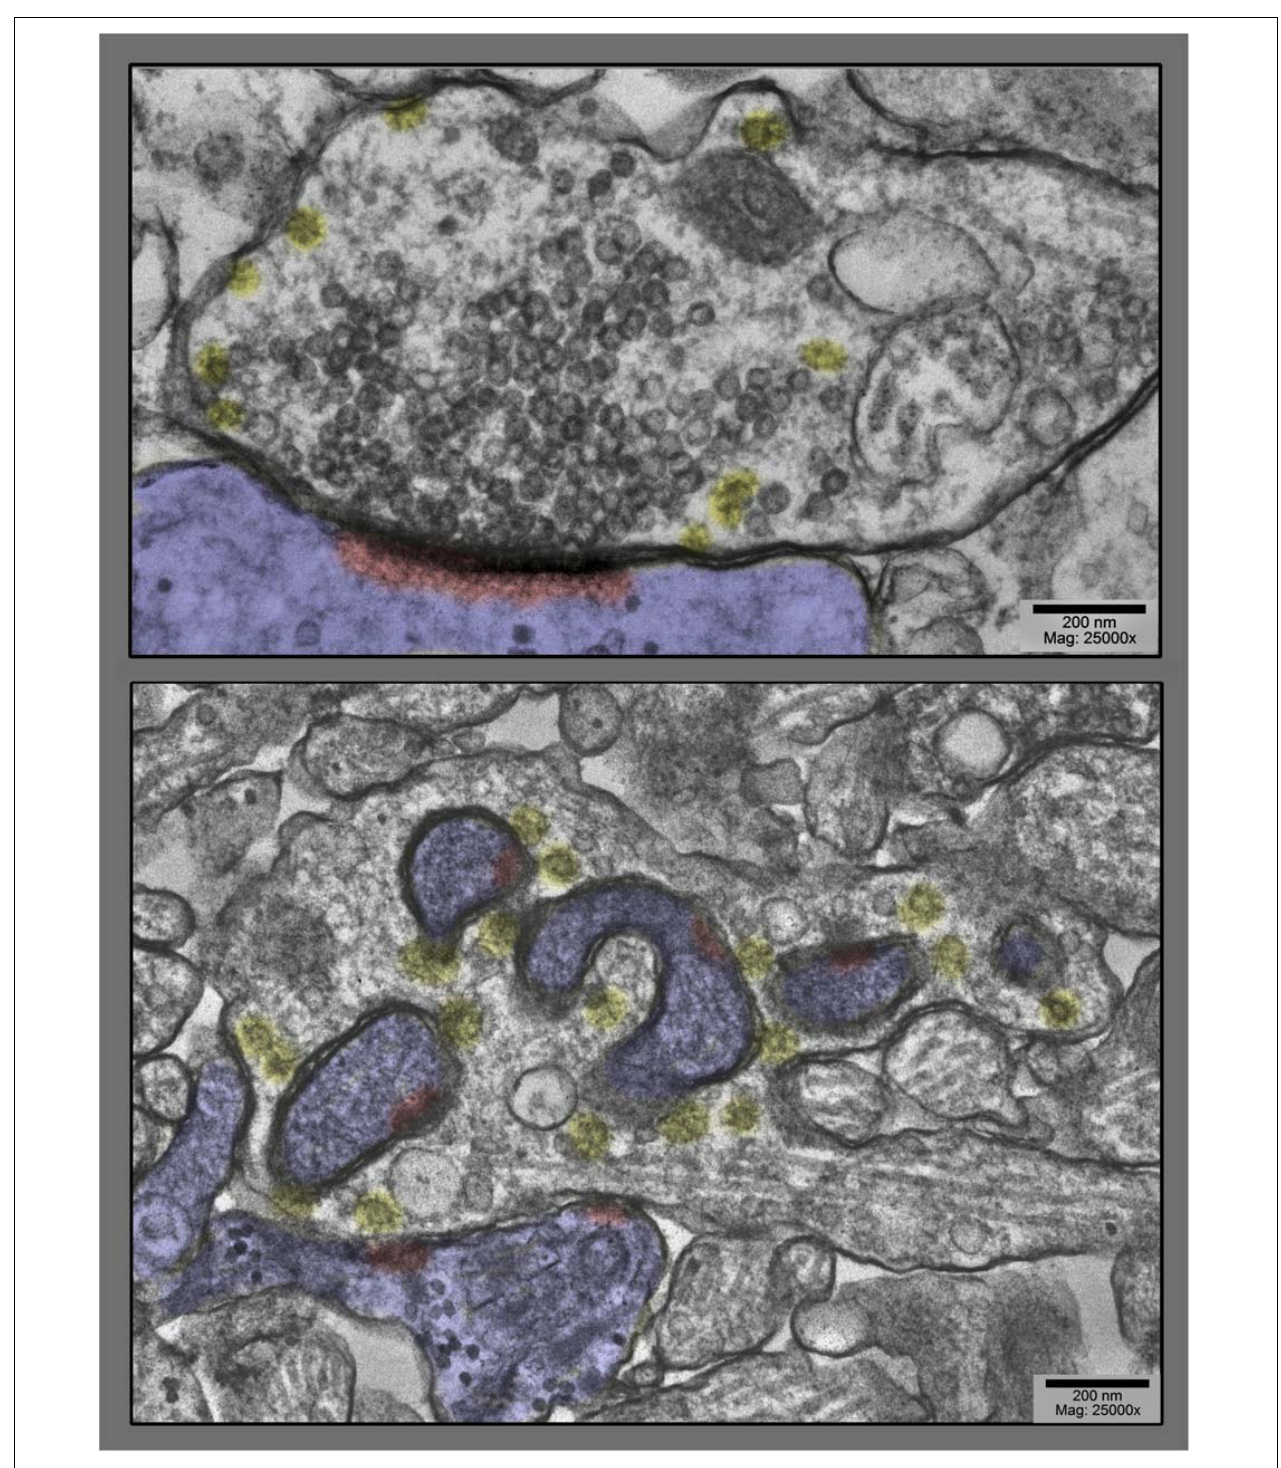
FIGURE 1 | Upper panel shows a prototypical spine synapse from a control hippocampal culture, a culture not stimulated at all. Abundant synaptic vesicles are collected on the presynaptic side, converging on a solid, disk or plaque-like postsynaptic density (highlighted in red, inside the postsynapse, which is highlighted in blue in this and all subsequent figures). Only a few clathrin-coated vesicles are present (highlighted in yellow), and only at the periphery of the vesicle cluster. Lower panel shows, by way of contrast, a dramatically different spine synapse from a hippocampal culture exposed to 0.1 mM La + + + for 20 min at 37 ◦ C. Synaptic vesicles are severely depleted, clathrin-coated vesicles (yellow) are unusually abundant, and the postsynapse (highlighted in blue) has “protruded” into the presynapse at several places, dragging along only fragments of the PSD (highlighted in red).